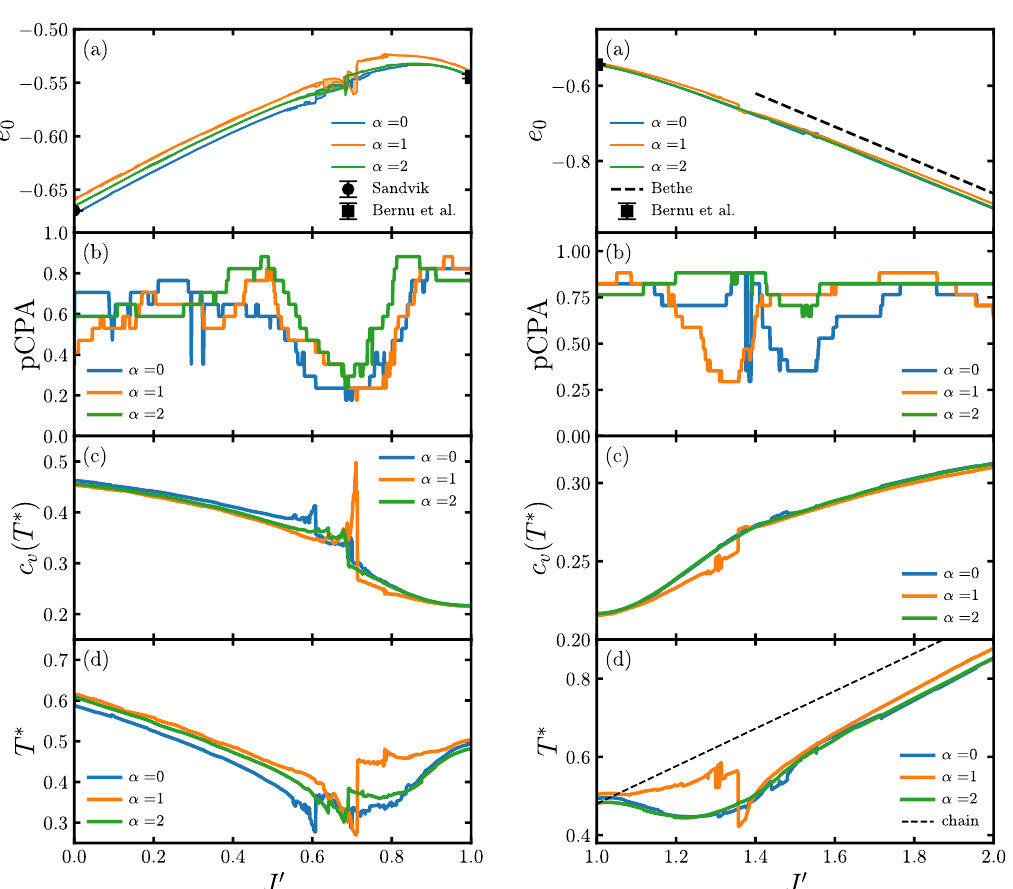
Figure 6: Entropy method results as a function of J (cid:48) using n = 16 for α = 0, 1, and 2 (in blue, orange, and green, respectively). On the left panels, between the square ( J (cid:48) = 0) and triangular lattices ( J (cid:48) = 1); and on the right panels between the triangu- lar lattice and J (cid:48) = 2. Panels show: (a) the ground-state energy with corresponding uncertainties (black symbols correspond to ED [ 8 ] and QMC [ 54 ] and the dashed line corresponds to the exact energy of a single chain [ 55 ] ); (b) the proportion of coinciding PAs; (c) the value of the peak in the specific heat; (d) the temperature at which the peak appears (In black dashed lines are the results for the single chain with α = 1 at order